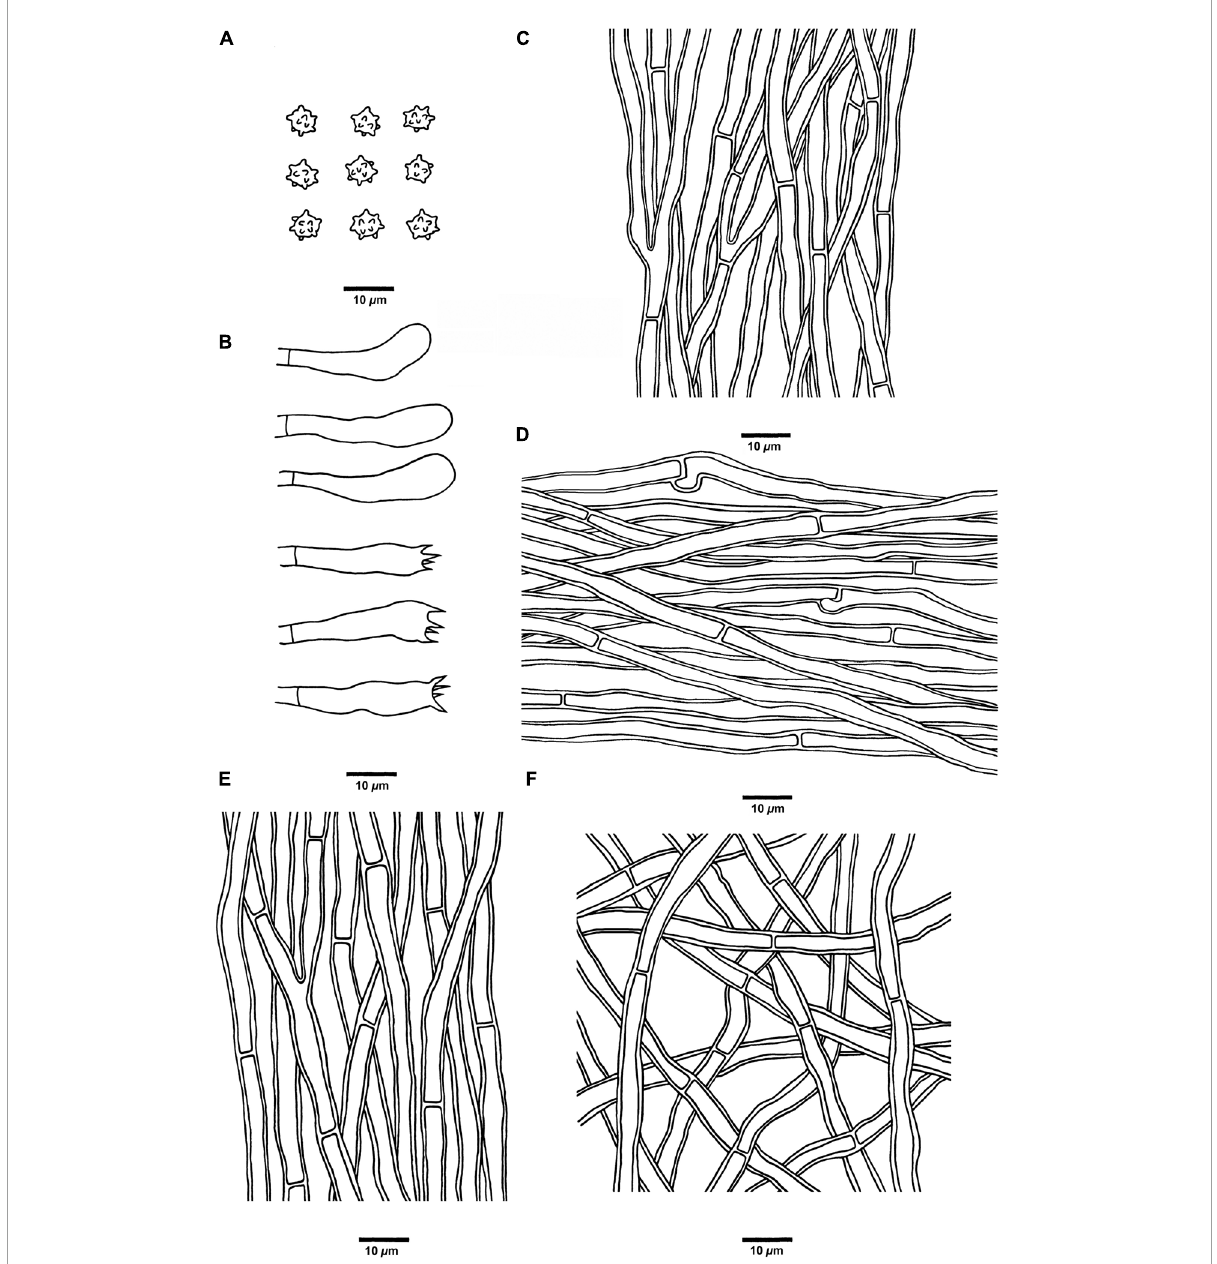
FIGURE8 Microscopic structures of H. melanocarpum (drawn from Cui 18556). (A) Basidiospores, (B) Basidia and basidioles, (C) Hyphae from context, (D) Hyphae from spines, (E) Hyphae from the inner layer of stipe, and (F) Hyphae from the surface layer of stipe.